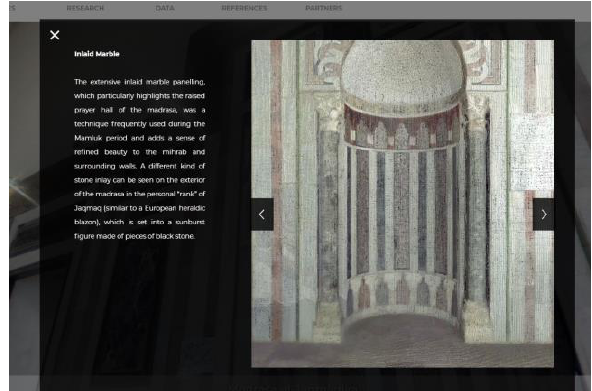
Figure 5. • Madrasa al-Jaqmaqiya– Virtual Tour Hotspot, Inlaid Marble (More Information)